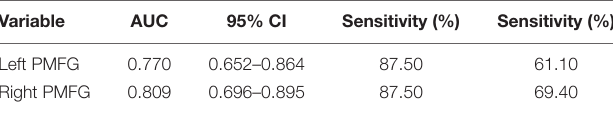
TABLE 3 | Receiver operating characteristic results predicting cognitive status in PD patients based on the significant functional connectivity with the left PMFG and right PMFG,